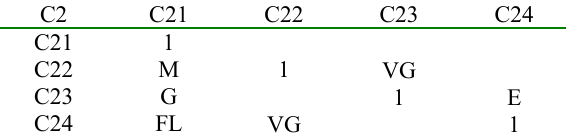
Table 9. Linguistic evaluation matrix of DM2 for C2 sub-criteria